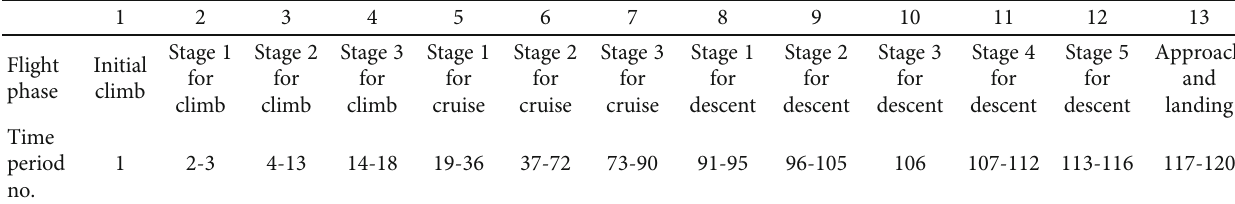
Table 2: Time period allocation for the fl ight phase.